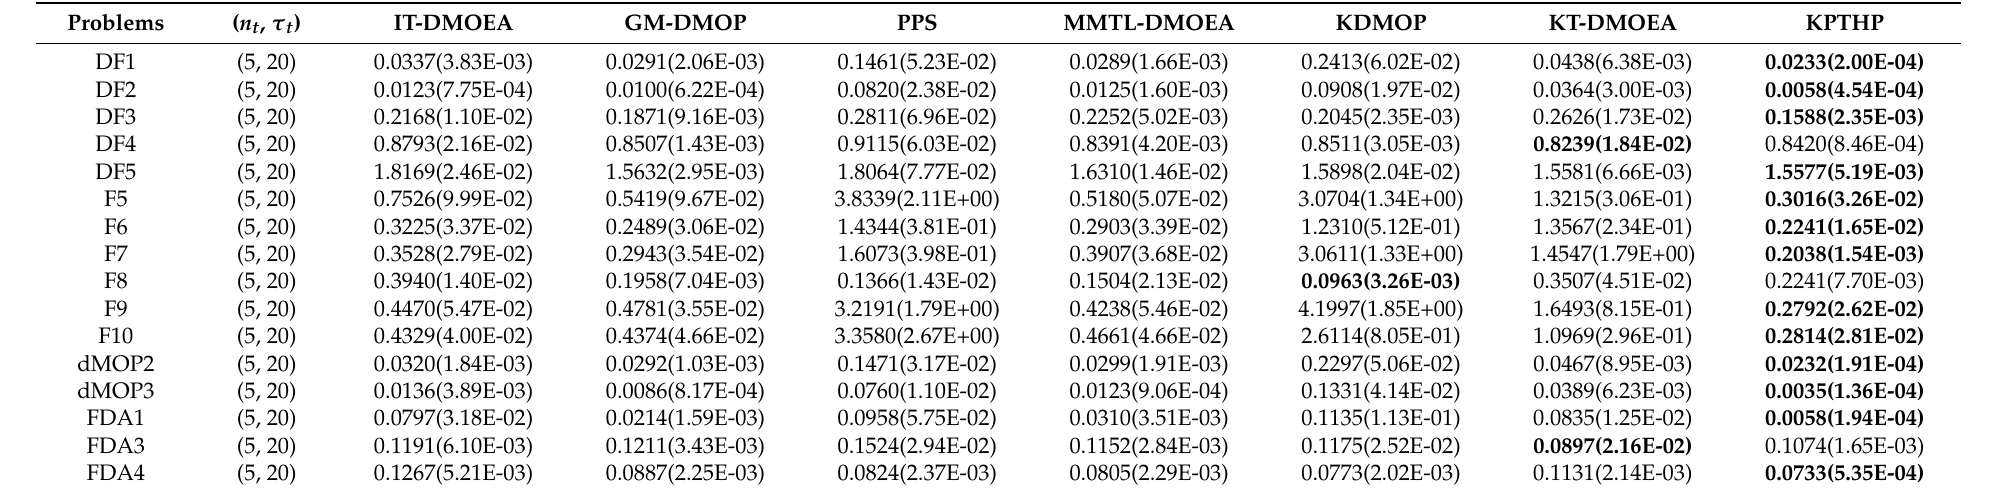
Table 2. Mean and SD of MIGD indicator obtained by seven algorithms for ( n t , τ t ) = (5, 20).